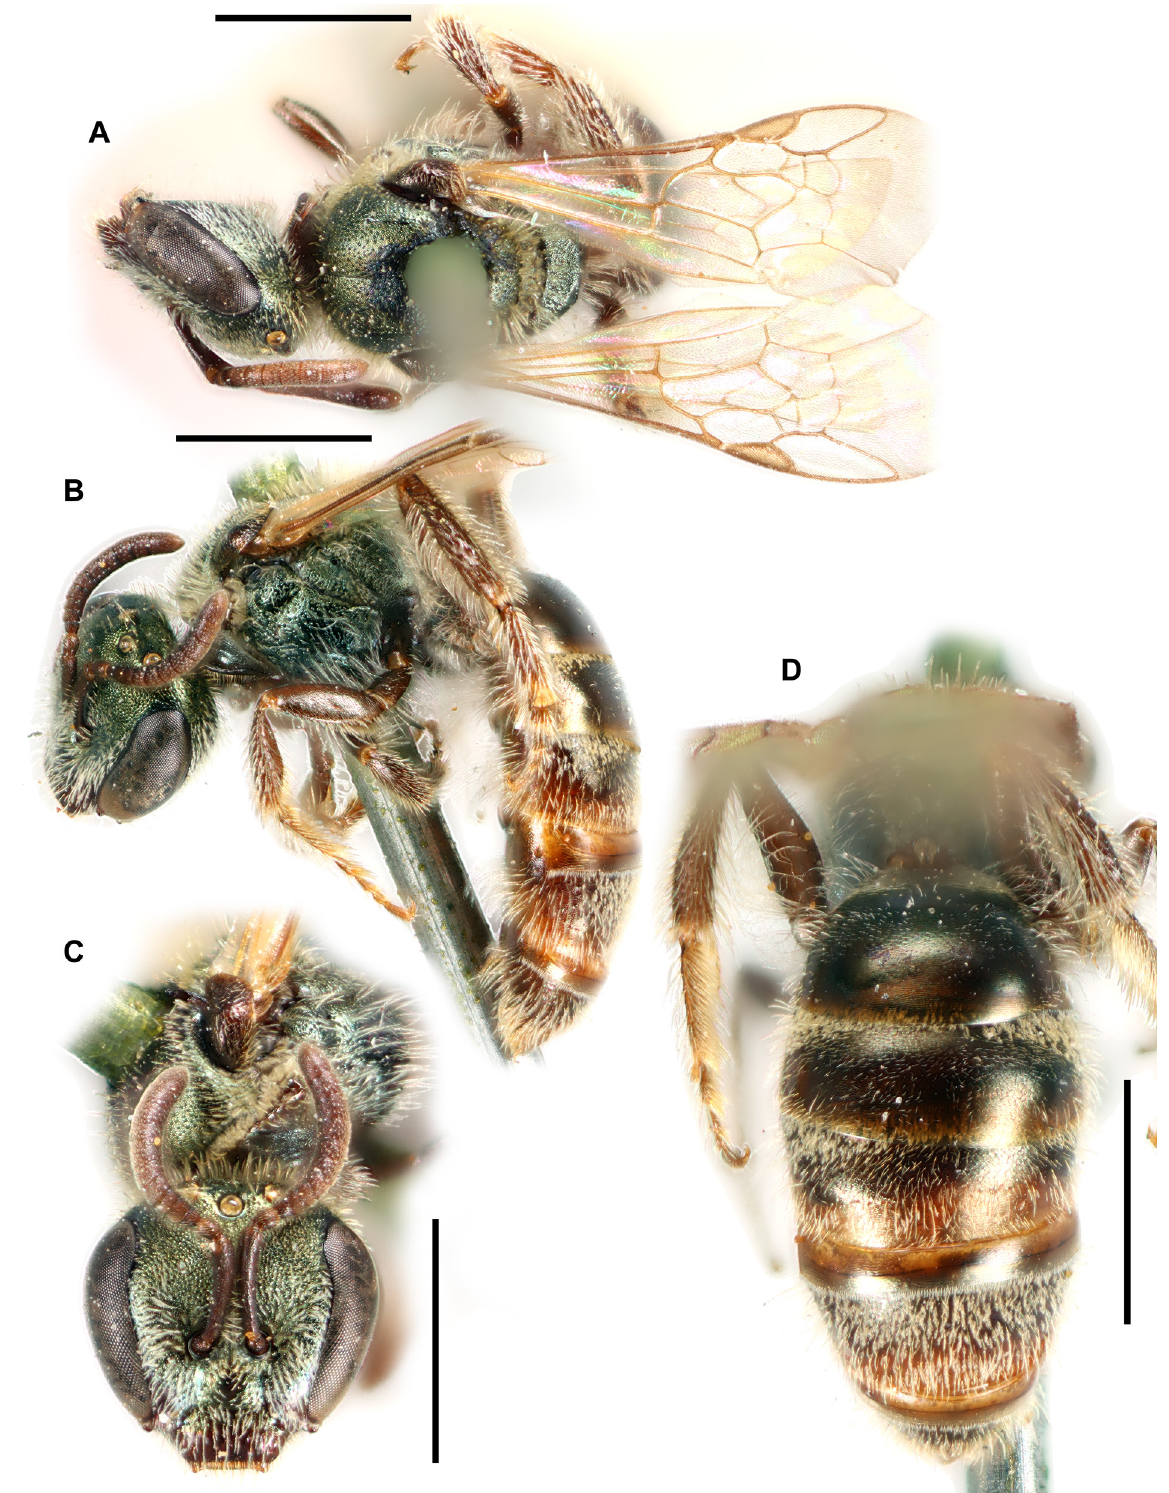
Fig. 51. Lasioglossum ( D .) pseudotegulare (Cockerell, 1896), ♀, holotype (USNM 12065). A . Dorsal habitus. B . Lateral habitus. C . Face. D . Metasoma. Scale bars = 1